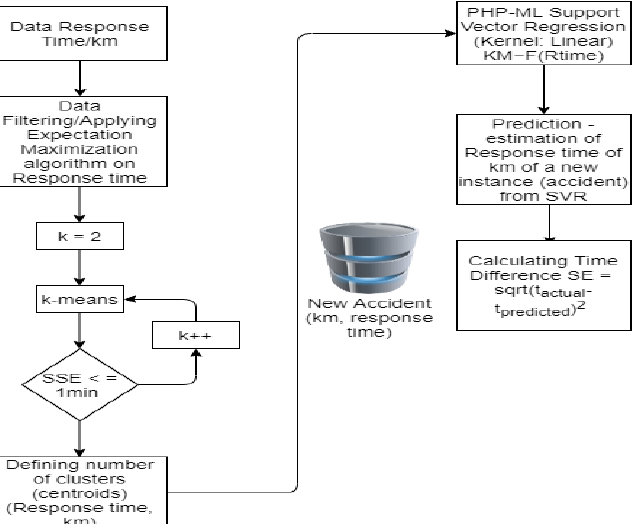
Figure 5. Illustration of the response time algorithm steps. Estimation of Response Time of motor- way’s field personnel when an incident occurs.